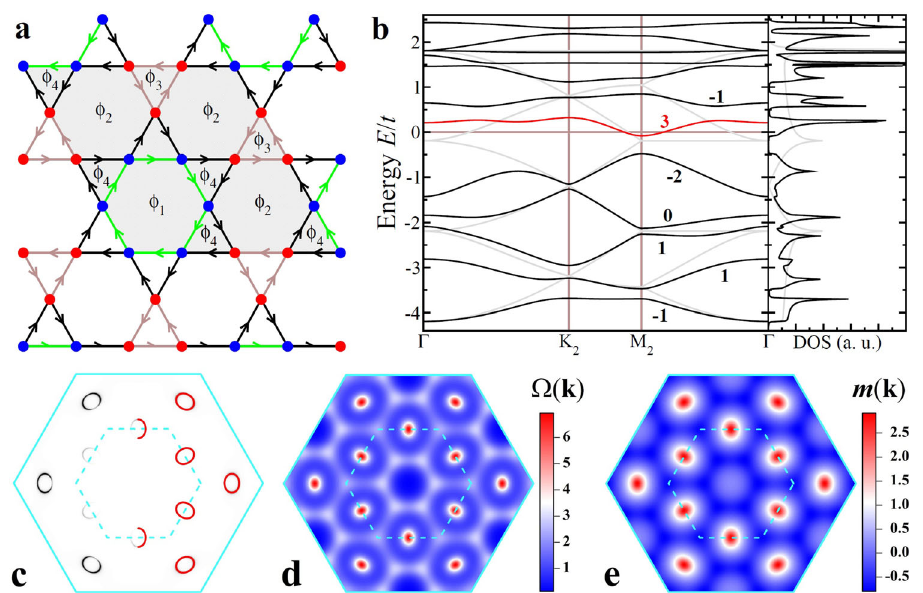
Fig. 2 | Complex CDW and Chern Fermi pockets. a Schematics of the 2 a 0 ×2 a 0 CDWstate. Electron densityis0.878(0.810) on the red (blue)sites. Three complex hoppings on the black, green, and brown bonds are 0.499±0.123 i , 0.345±0.162 i , and 0.349±0.110 i , respectively, giving rise to four independent plaquette fl uxes − 0.028, − 0.291,0.014) π .Thenet fl uxthroughtheunitcell(shaded ϕ 1, … ,4 =(0.840, grey) is zero. b Band dispersion in the folded BZ and DOS. Bands are marked by